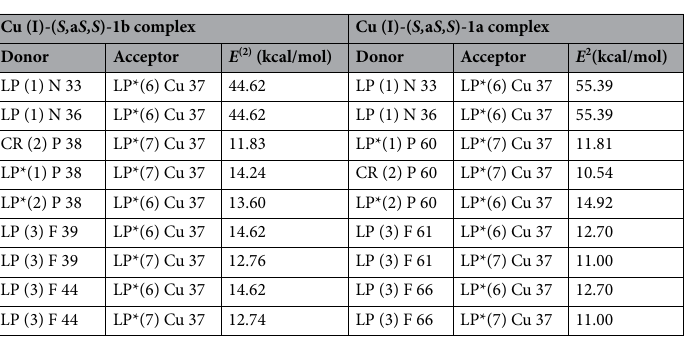
Table 3. E (2) parameter on selected atoms of the Cu (I)-( S,aS,S )-complexes using NBO calculation.